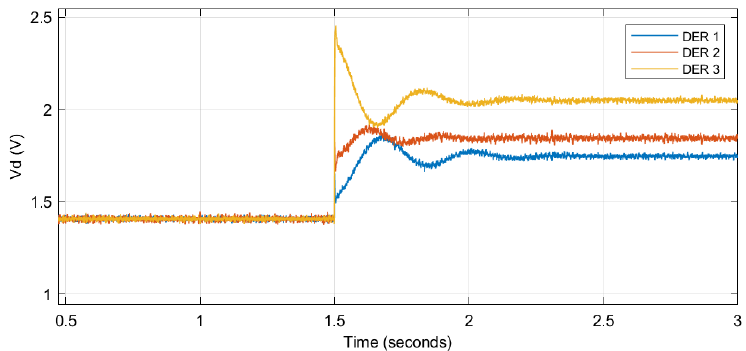
Figure 5. v dpd drop in voltage due to proposed virtual impedance.